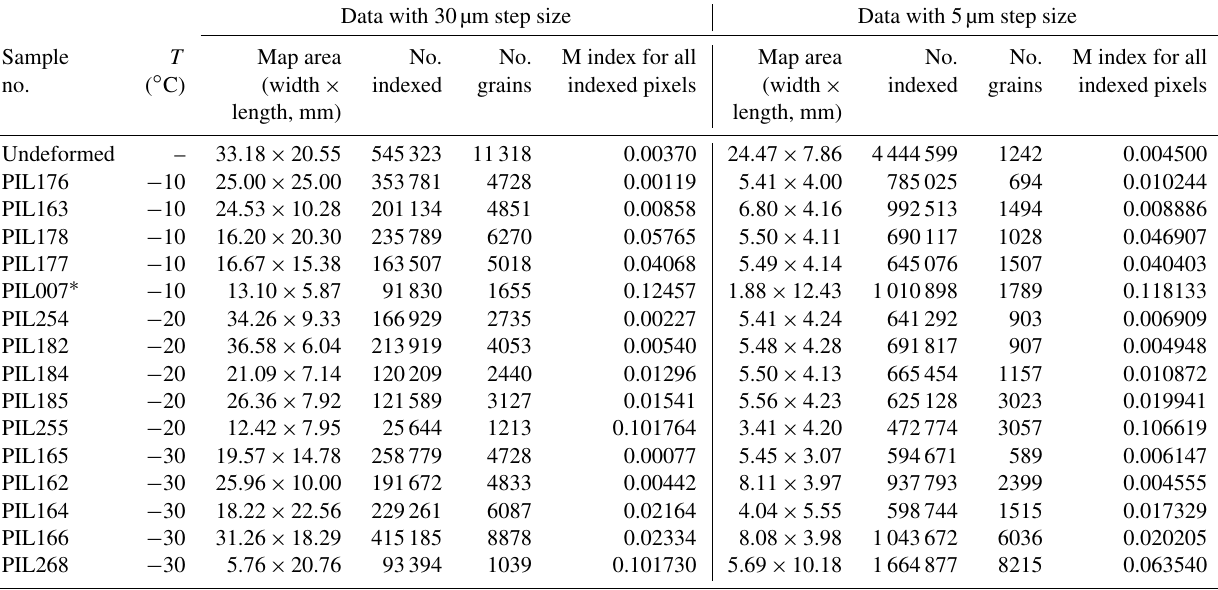
Table 2. Summary of EBSD